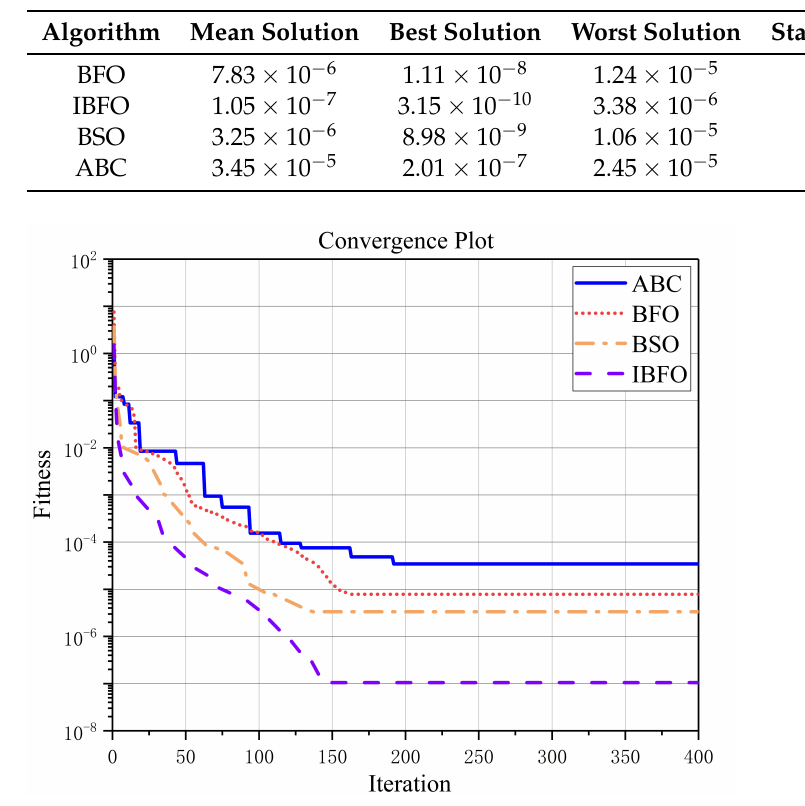
Figure 6. Evolutionary process of average fitness value for different